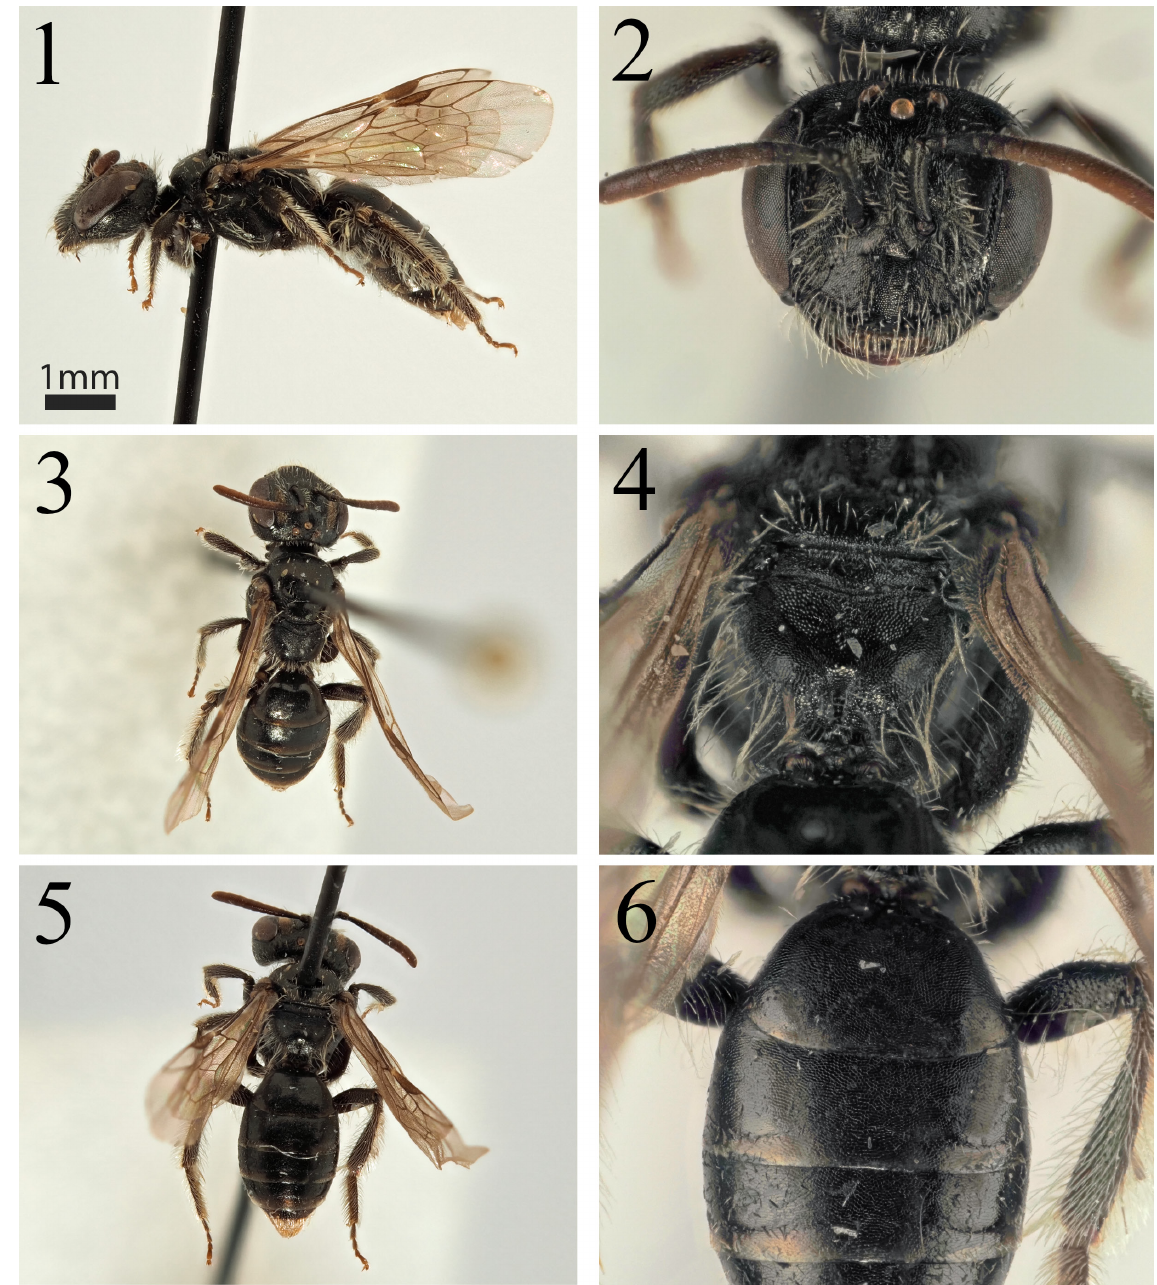
Figs 1–6. Andrena deminuta Wood sp. nov., ♀ (OÖLM). 1 . Profile. 2 . Face. 3 . Dorsum. 4 . Propodeal triangle. 5 . Terga. 6 .